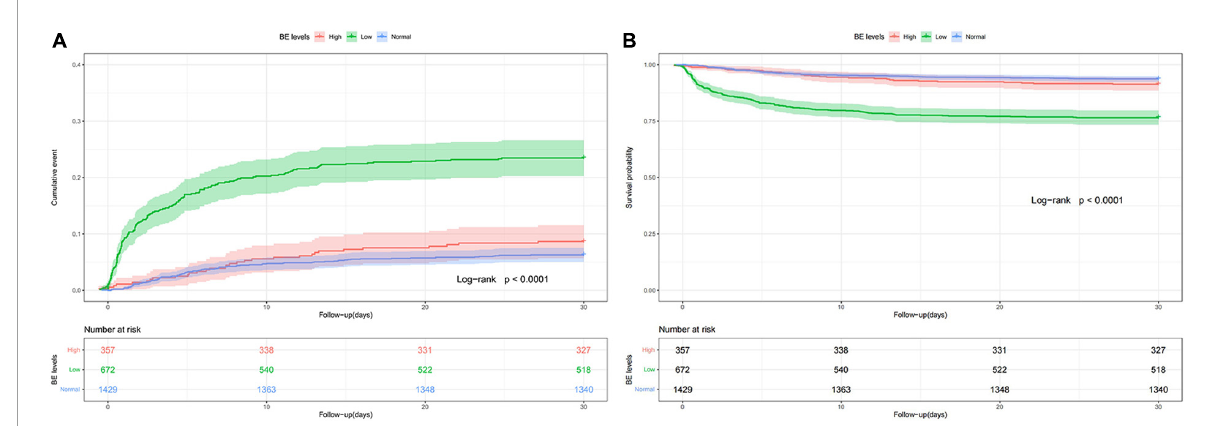
FIGURE1 Cumulative incidence (A) and Kaplan-Meier curve (B) of 28-day all-cause mortality stratified by base excess.